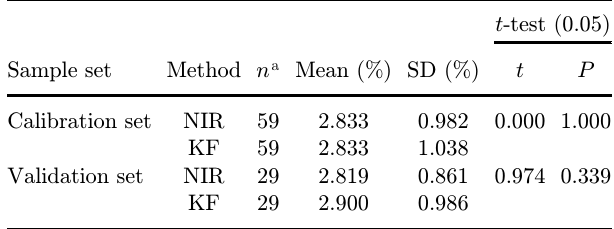
Table 5. Statistical results of paired t